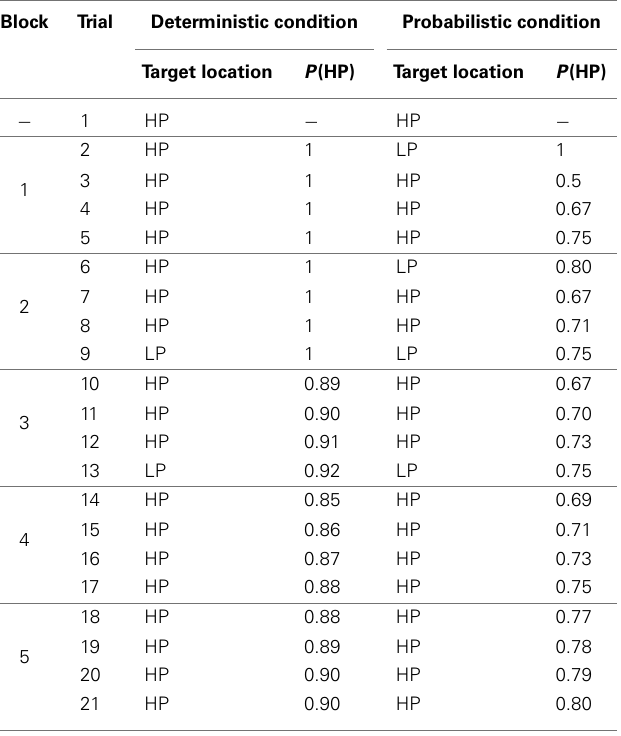
Table 1 |Target location for each trial (HP, High Probability side; LP, Low-Probability